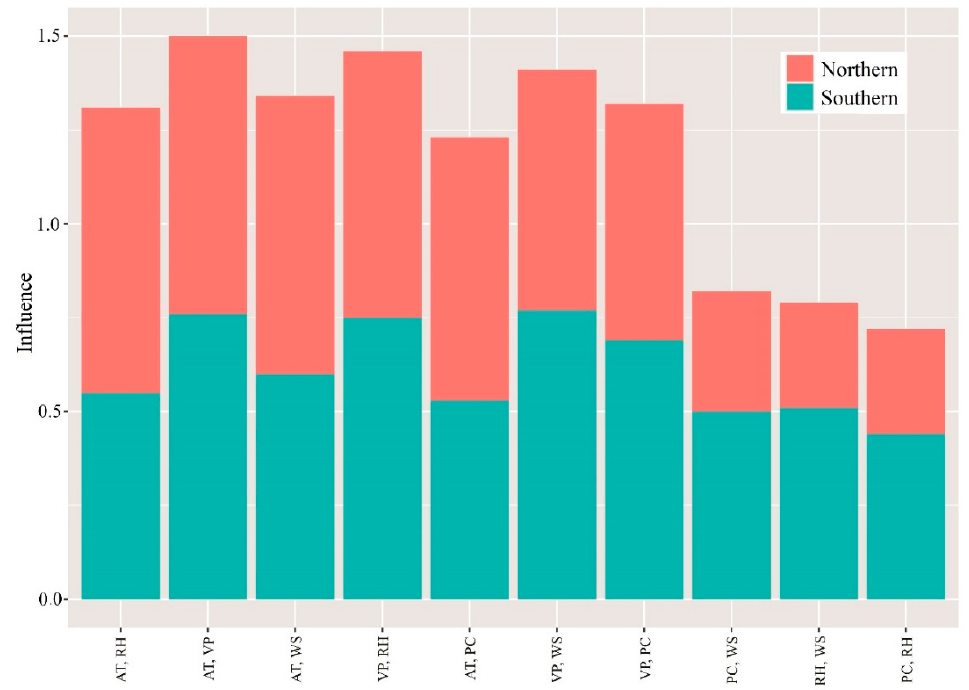
Figure 6. Interactions among meteorological factors in Northern and Southern China. Note: AT: average temperature; VP: vapor pressure; PC: precipitation; RH: relative humidity; WS: wind speed.